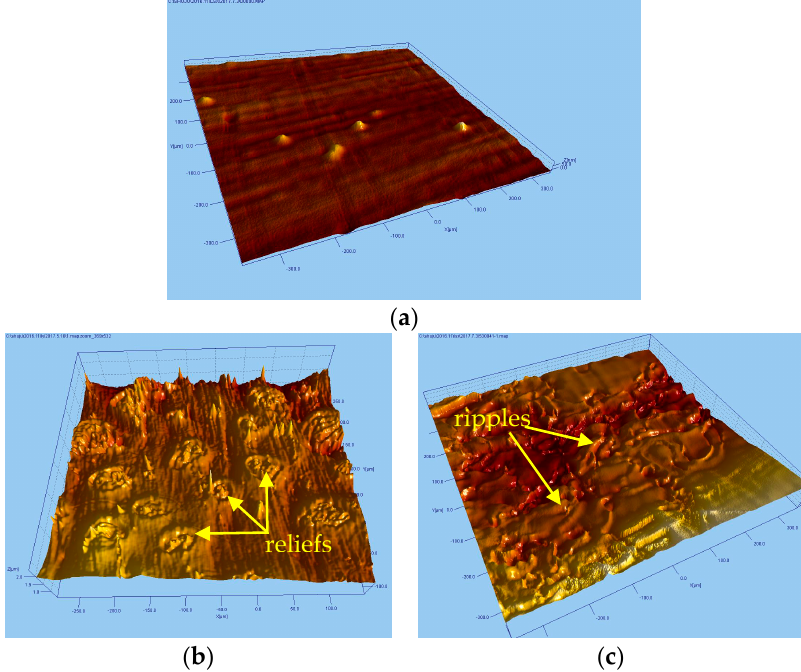
Figure 2. The surface morphology of different surfaces after the treatment of ( a ) the original surface, ( b ) LSP, and ( c ) WLSP.